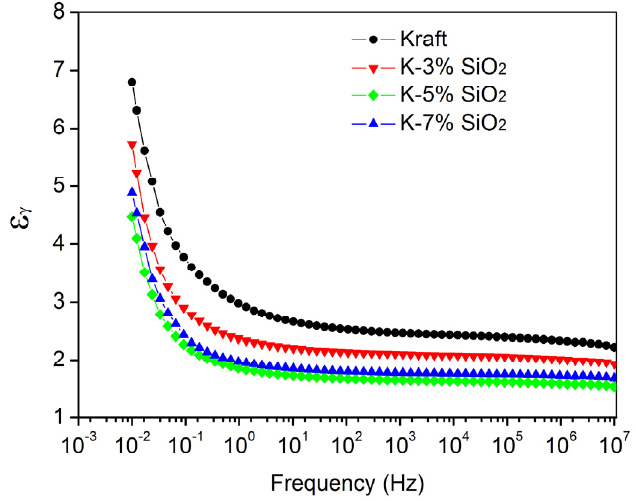
hollow sphere content on the relative permittivity of insulation Figure 2. Effect of SiO 2